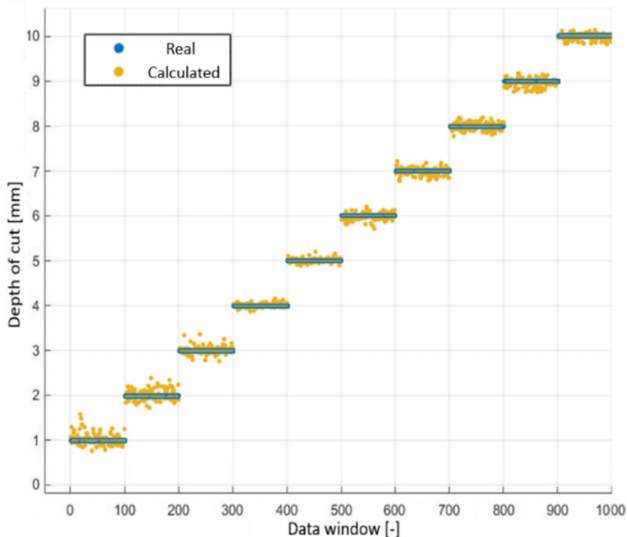
Figure 10. Depth values calculated using the regression model with a feed rate of 0.12 mm at 1200